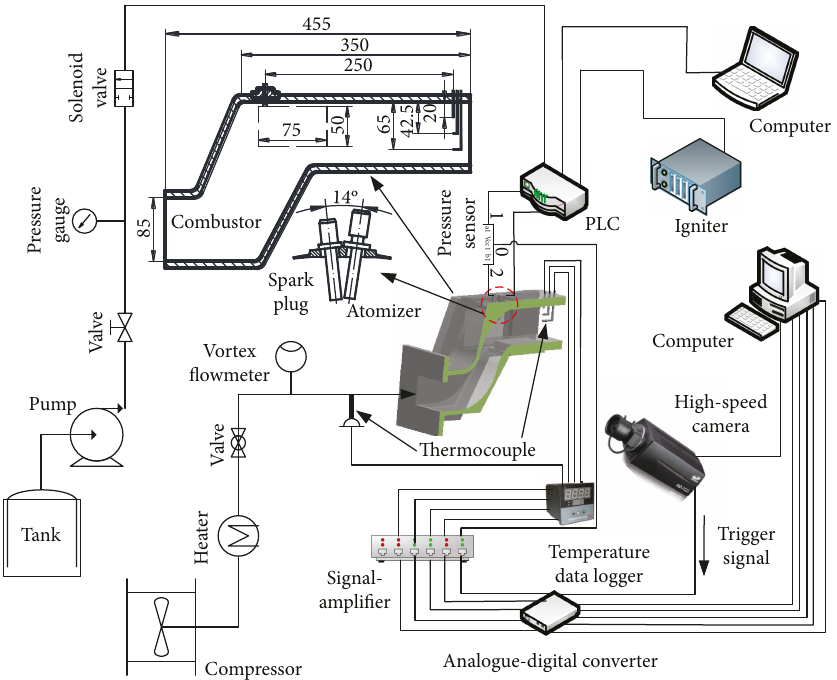
Figure 1: Schematic of ignition experimental system for spray